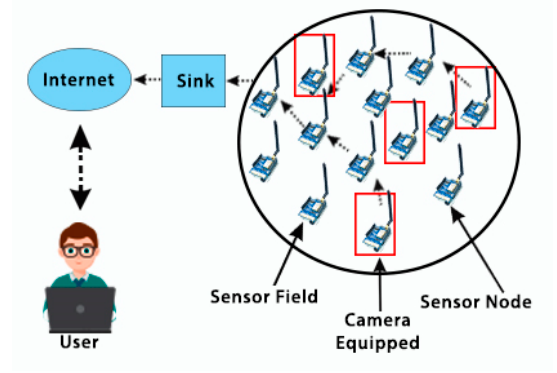
Figure 3. Composition of a wireless sensing network (WSN) [1].